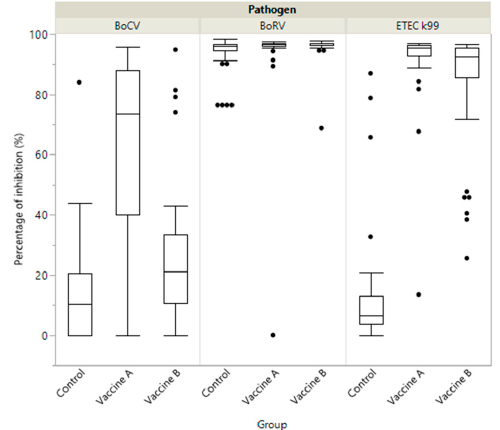
Figure 2. Boxplot showing specific immunity represented as a percentage of inhibition (PI) of antibody titre in colostrum by study group (Vaccine A, Vaccine B and Control) against: coronavirus (BoCV); enterotoxigenic E. coli ( ETEC K99 ) and Rotavirus (BoRV).